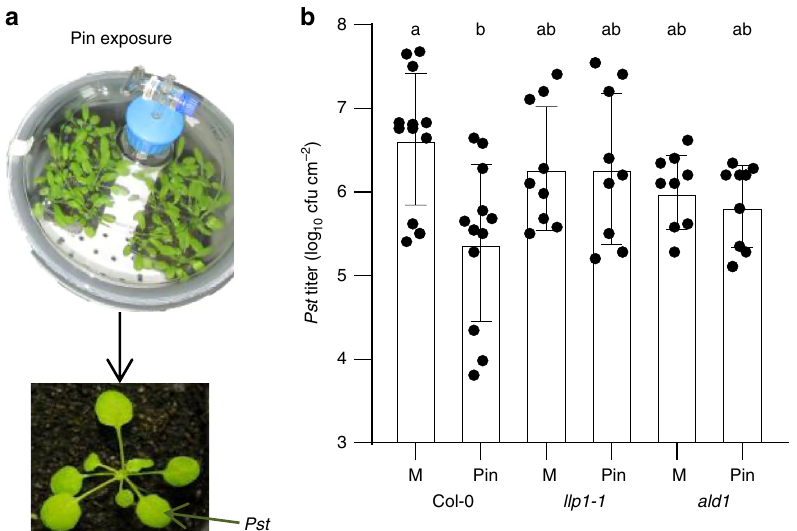
Fig. 3 LLP1 and Pip act downstream of volatile monoterpenes in pinene-induced resistance. a Setup of a pinene fumigation experiment. Plants were exposed to a mixture of α - and β -pinene (molar ratio 1:1; Pin) in air-tight glass containers or to the solvent hexane as the mock (M) control treatment. The plants were subsequently released from the containers and inoculated in the leaves with Pst . b In planta Pst titers at 4 dpi of pinene (Pin)- or mock (M)-treated plants. The plant genotypes are indicated below the panel and include ald1 with compromised Pip accumulation. Dots indicate individual results from three to four biologically independent experiments per genotype and treatment (including three replicates each). Bars represent the average of the indicated results ± standard deviation. Different letters above bars indicate signi fi cant differences, one-way ANOVA, P <